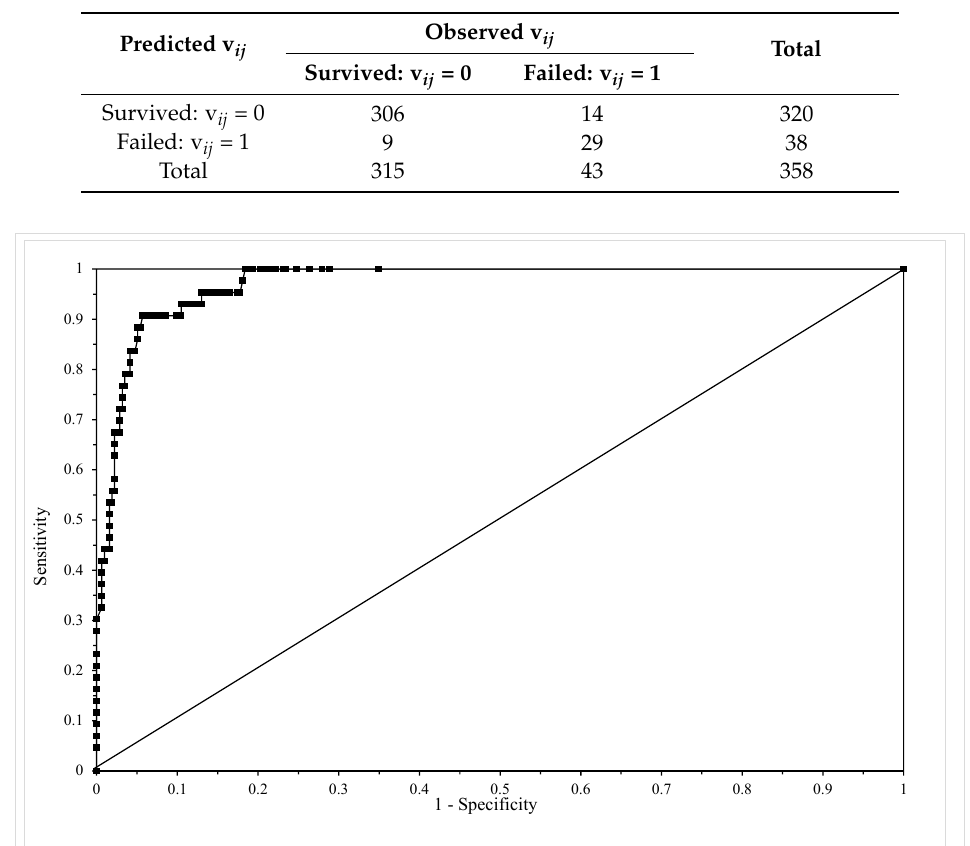
Figure 5. The receiver operating characteristic (ROC) from model given by Equation (13e).